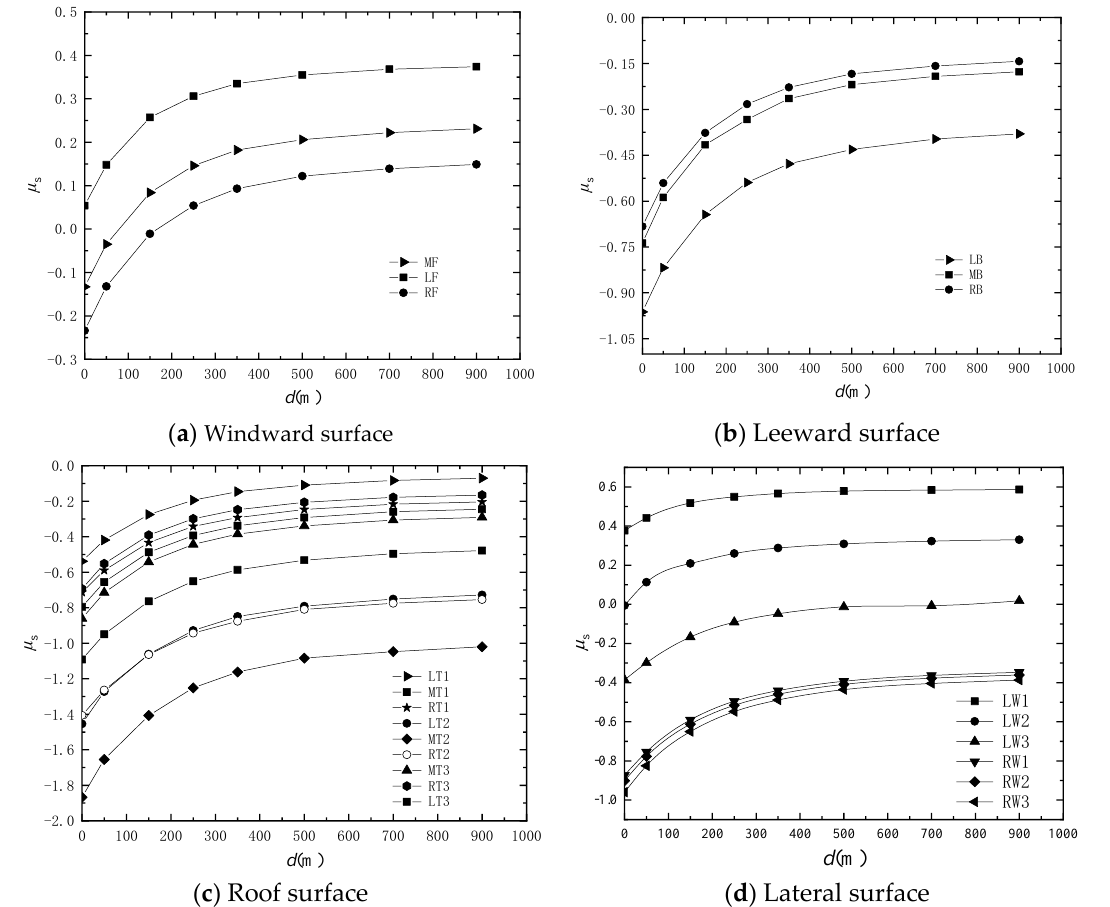
Figure 14. Wind pressure coefficient in each area of the greenhouse with 45° azimuth.